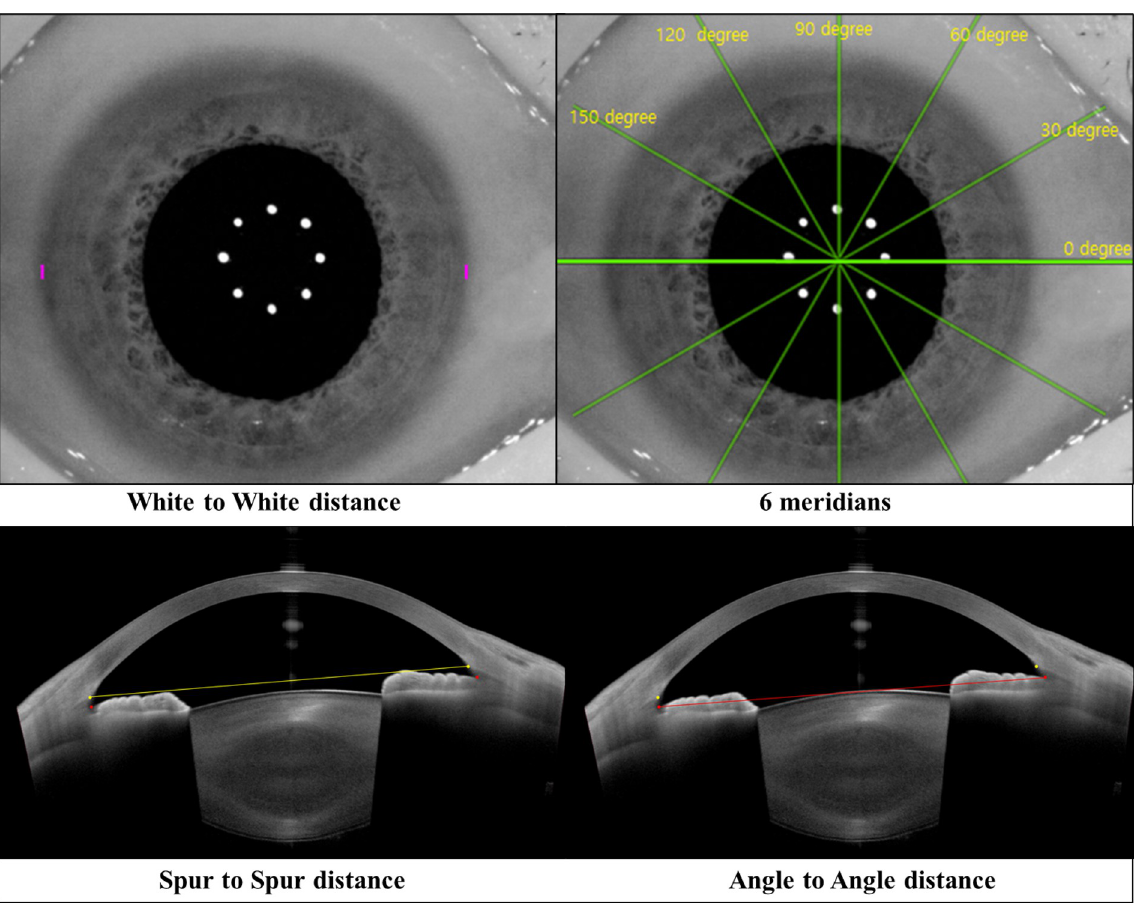
Fig 1. White to white, spur to spur, and angle to angle distances at the 0 degree (horizontal) meridian, and 6 meridians measured with the anterion swept source optical coherence tomography.